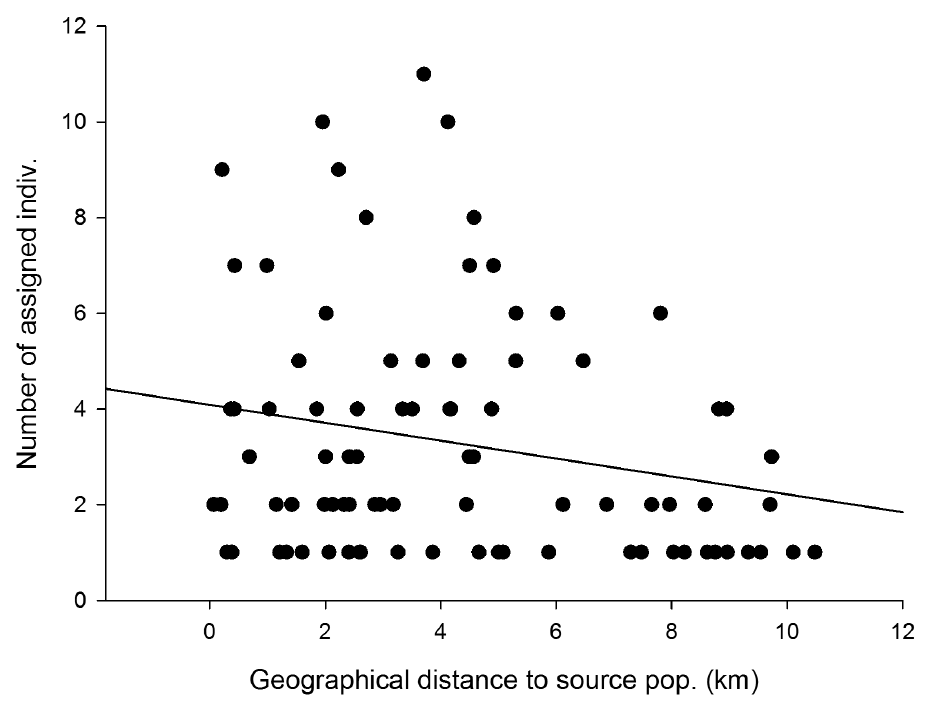
Figure 6. Isolation effect on genetic assignment. Correlation between the number of individuals of recent populations assigned to a source (old) population and the distance of the recent population to this source population ( b =–0.25, P =0.018). Data points represent assignment data from all 14 recent populations (Table 4).